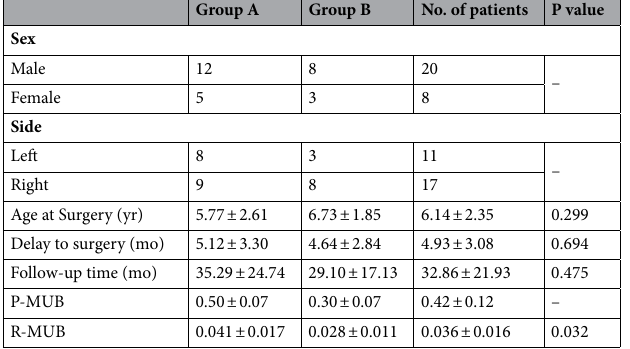
Table 1. Data of Group A and B. P-MUB the position of maximum ulnar bow, MUB the ratio of maximum ulnar